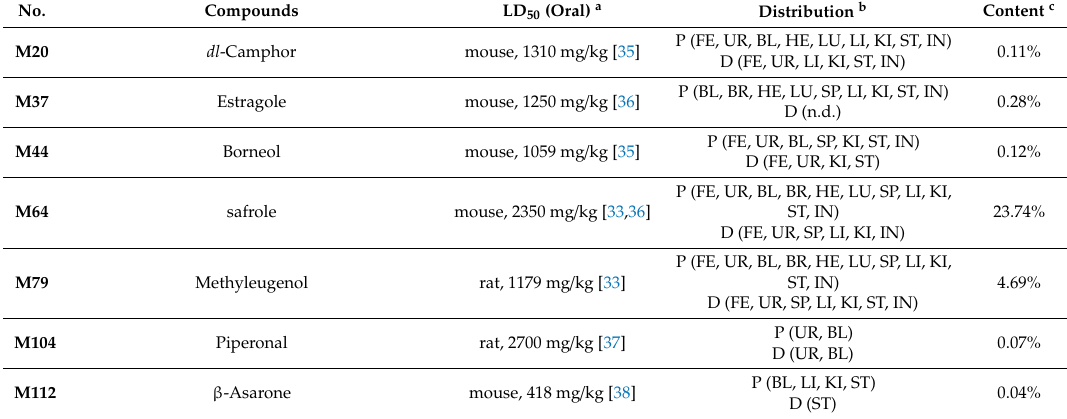
Acute toxicity and distribution of the compounds identified in the blood of powder-treated